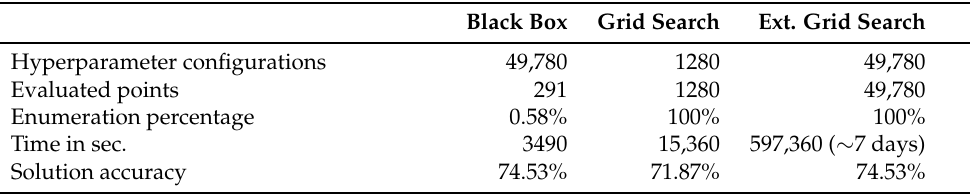
Table 2. Comparison of black-box optimization and 2 variants of grid search for